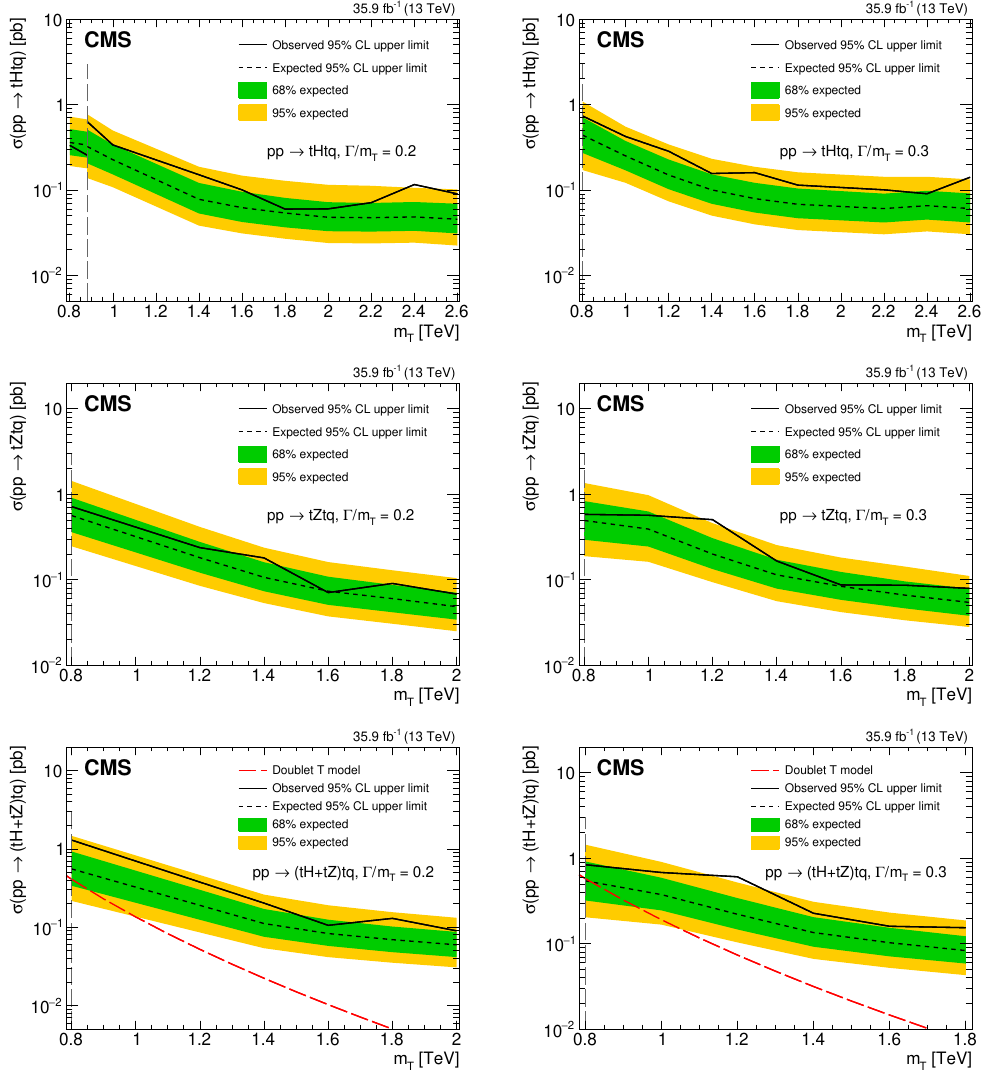
Figure 11 . The observed and median expected upper limits at 95% CL on the cross sections for production associated with a top quark for the tHtq (upper row) and tZtq (middle row) channels, and their sum, tHtq+tZtq (lower row), for di(cid:11)erent assumed values of the T quark mass. The inner (green) band and the outer (yellow) band indicate the regions containing 68 and 95%, respectively, of the distribution of limits expected under the background-only hypothesis. The left column is for a fractional width of 20% and the right column is for a fractional width of 30%. The vertical dashed lines are the crossover points in sensitivity that indicate the mass intervals used for presenting the low-mass and high-mass search results. The dashed red curves are for the (TB) doublet model. Given the speci(cid:12)ed width, the couplings are implicit in the model.